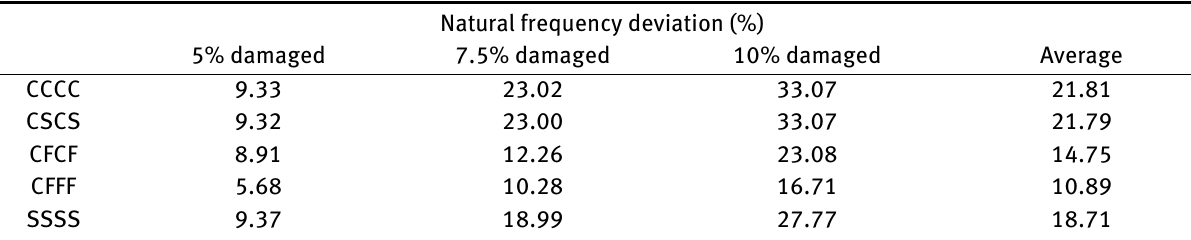
Table 4: Effect of the boundary condition on the natural frequency deviation.